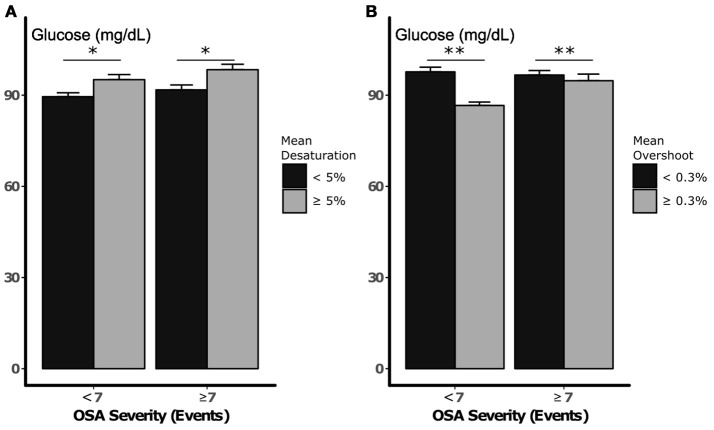
Nocturnal glucose vs. desaturation depth (A) and SPO2 overshoot (B), during periods of low and high sleep apnea density. Error bars represent standard errors. *p < 0.10 and **p < 0.05, respectively, for independent association between mean desaturation depth and SPO2 and nocturnal glucose. Statistical analysis did not demonstrate an independent or interactive association between sleep apnea density and glucose during sleep.